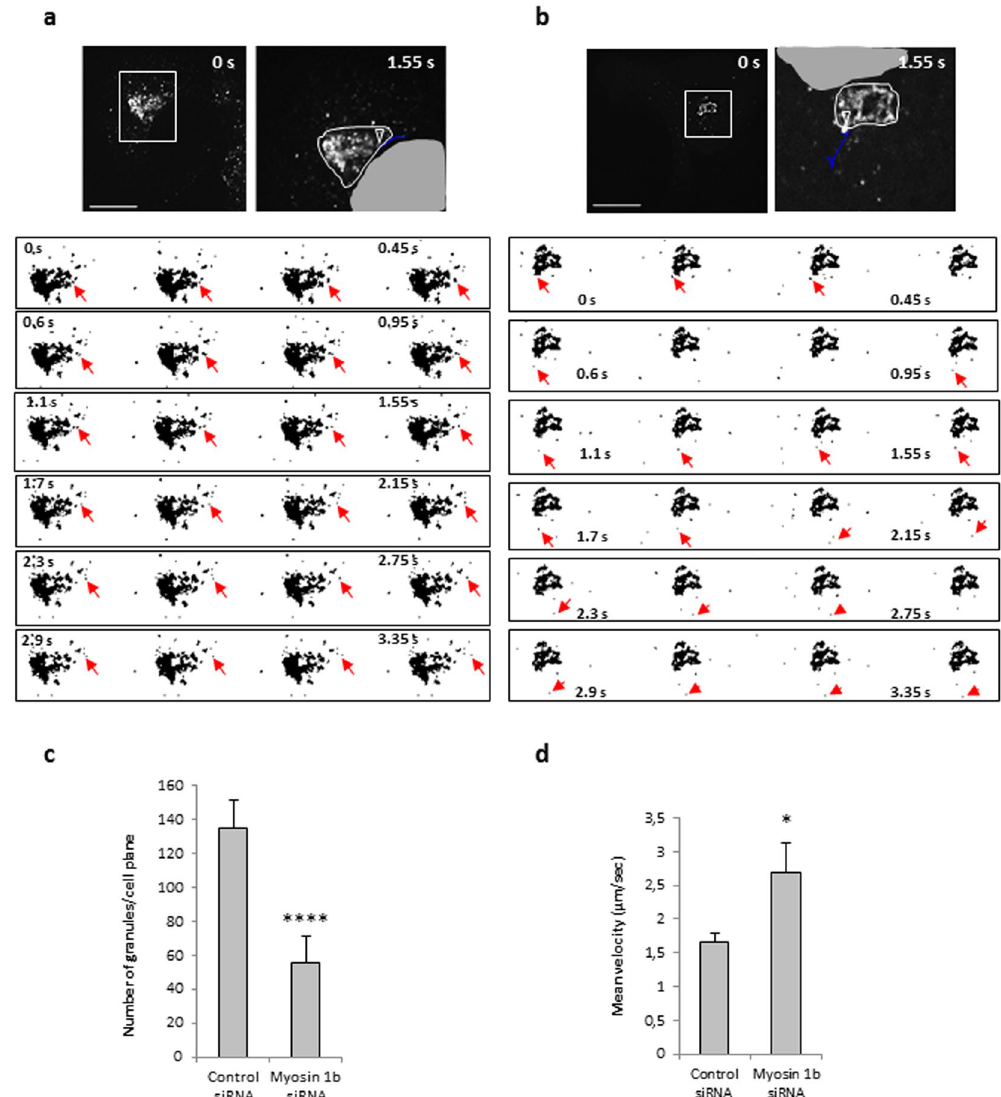
Figure 3. Myo1b depletion alters the number and the velocity of CgA granules. COS7 cells were first transfected with control siRNA ( a ) or myosin1b siRNA ( b ), and 24 h later with a plasmid encoding CgA- GFP. CgA-GFP carriers were monitored 5 h later at 37 °C by time-lapse imaging using spinning-disc confocal microscopy (see Movies 1 and 2). The first frames of representative movies (that cover 3.5 s) revealing the sequence of events of granule formation are shown. White boxes indicate the enlarged TGN region shown in image sequences. The right image in each panel corresponds to the enlarged region showing granule trajectory (in blue) along the image sequence, using the ‘manual tracking’ plugin of Image J. The arrow head indicates the position of the granule at the beginning of the tracking. The white line delimitates the Golgi region and the grey zone corresponds to part of the nucleus. The scale bars represent 10 µ m. The red arrows indicate the position of the tracked granule every 150 ms. ( c ) The number of CgA-GFP granules was quantified, and expressed as mean + s.e.m. from three independent experiments (n = 20–24 cells). **** P < 0.0001 (Mann-Whitney test). ( d ) The mean velocities were calculated as the cumulated displacement of the granule from the location of its first observation to the end of the observation period with respect to the time of observation, and expressed as mean + s.e.m. from three independent experiments (N = 14–19 cells, n = 22–69 granules). * P < 0.05 (Mann- Whitney